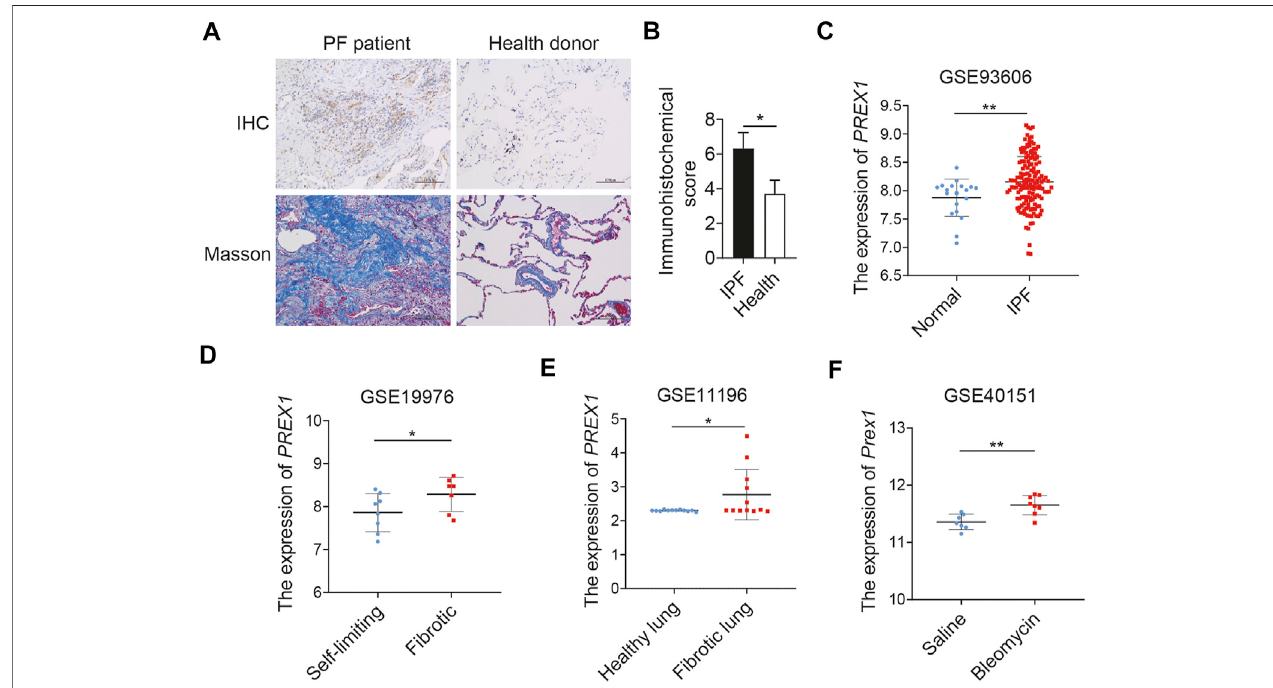
FIGURE 1 | P-Rex1 expression in pulmonary fi brosis. (A , B) Immunohistochemical staining and Masson ’ s trichrome staining of lung sections from patients with pulmonary fi brosis and healthy donors. Scale bars (cid:2) 100 μ m, n (cid:2) 5. (C – F) PREX1 mRNA expression was analyzed between pulmonary fi brosis and non-diseased controls using the public gene expression GEO datasets (GSE93606, GSE19976, GSE11196, and GSE40151) (* p < 0.05, and ** p <